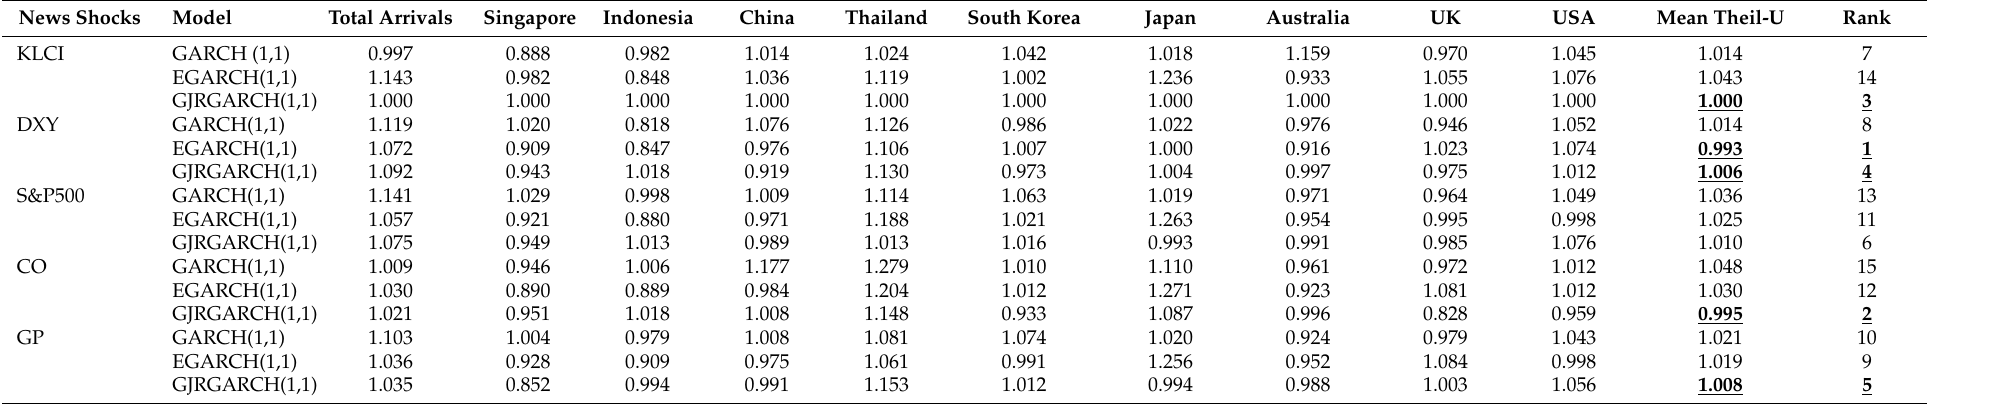
Table 10. Tourism demand volatility prediction methods based on MAE for in-sample one-step-ahead